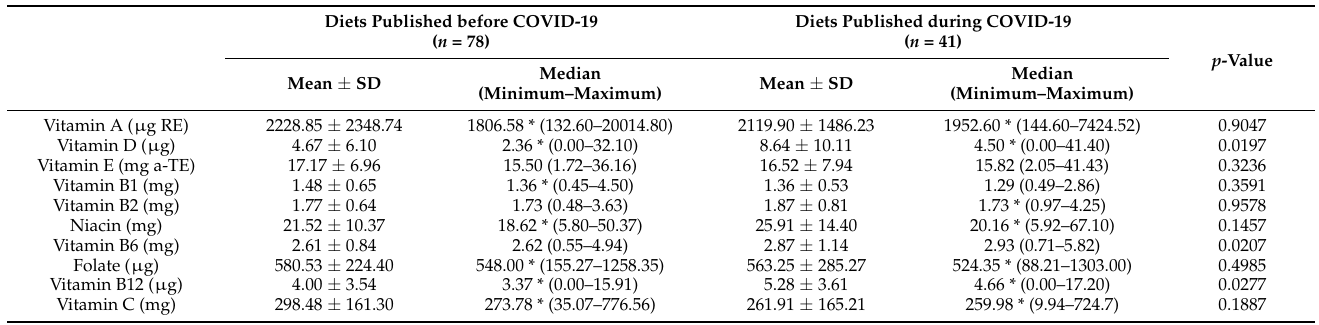
Table 6. The vitamin intake within the assessed single-day menus, stratified by year of publication, for the diets published before the COVID-19 pandemic and the diets published during the COVID-19